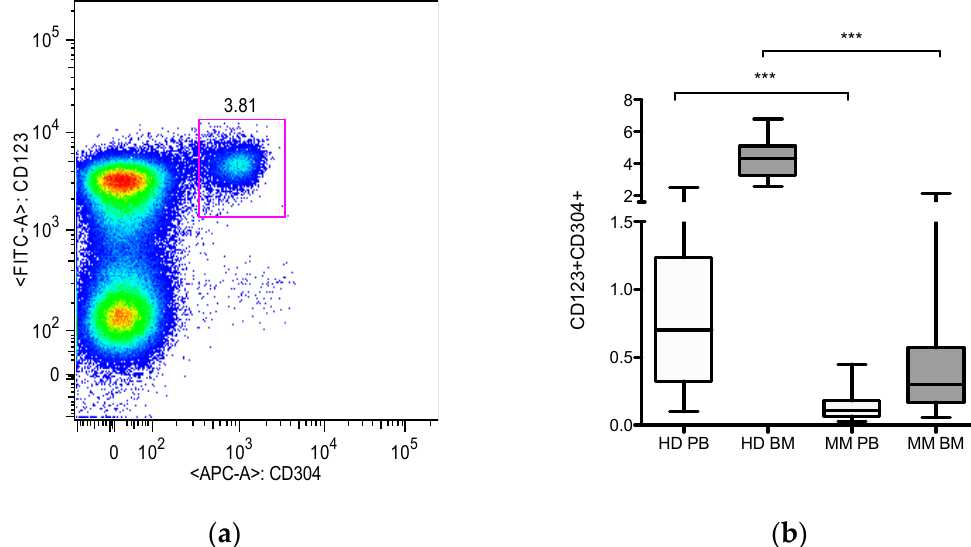
Figure 1. Plasmacytoid dendritic cells in healthy donors and multiple myeloma patients: ( a ) PDCs were analyzed by flow cytometry as CD123, CD303, CD304, and CD45 positive cells. Representative FACS analysis showing a pDC population in a MM patient; ( b ) PDC frequencies were analyzed in peripheral blood (PB, n = 53) and bone marrow (BM, n = 10) samples of healthy donors (HD) and compared to newly diagnosed myeloma patients (MM, n = 37). Each box shows the median with min and max values. Significant reductions of pDCs were determined as *** p < 0.0001 using the non-parametric Mann–Whitney test.